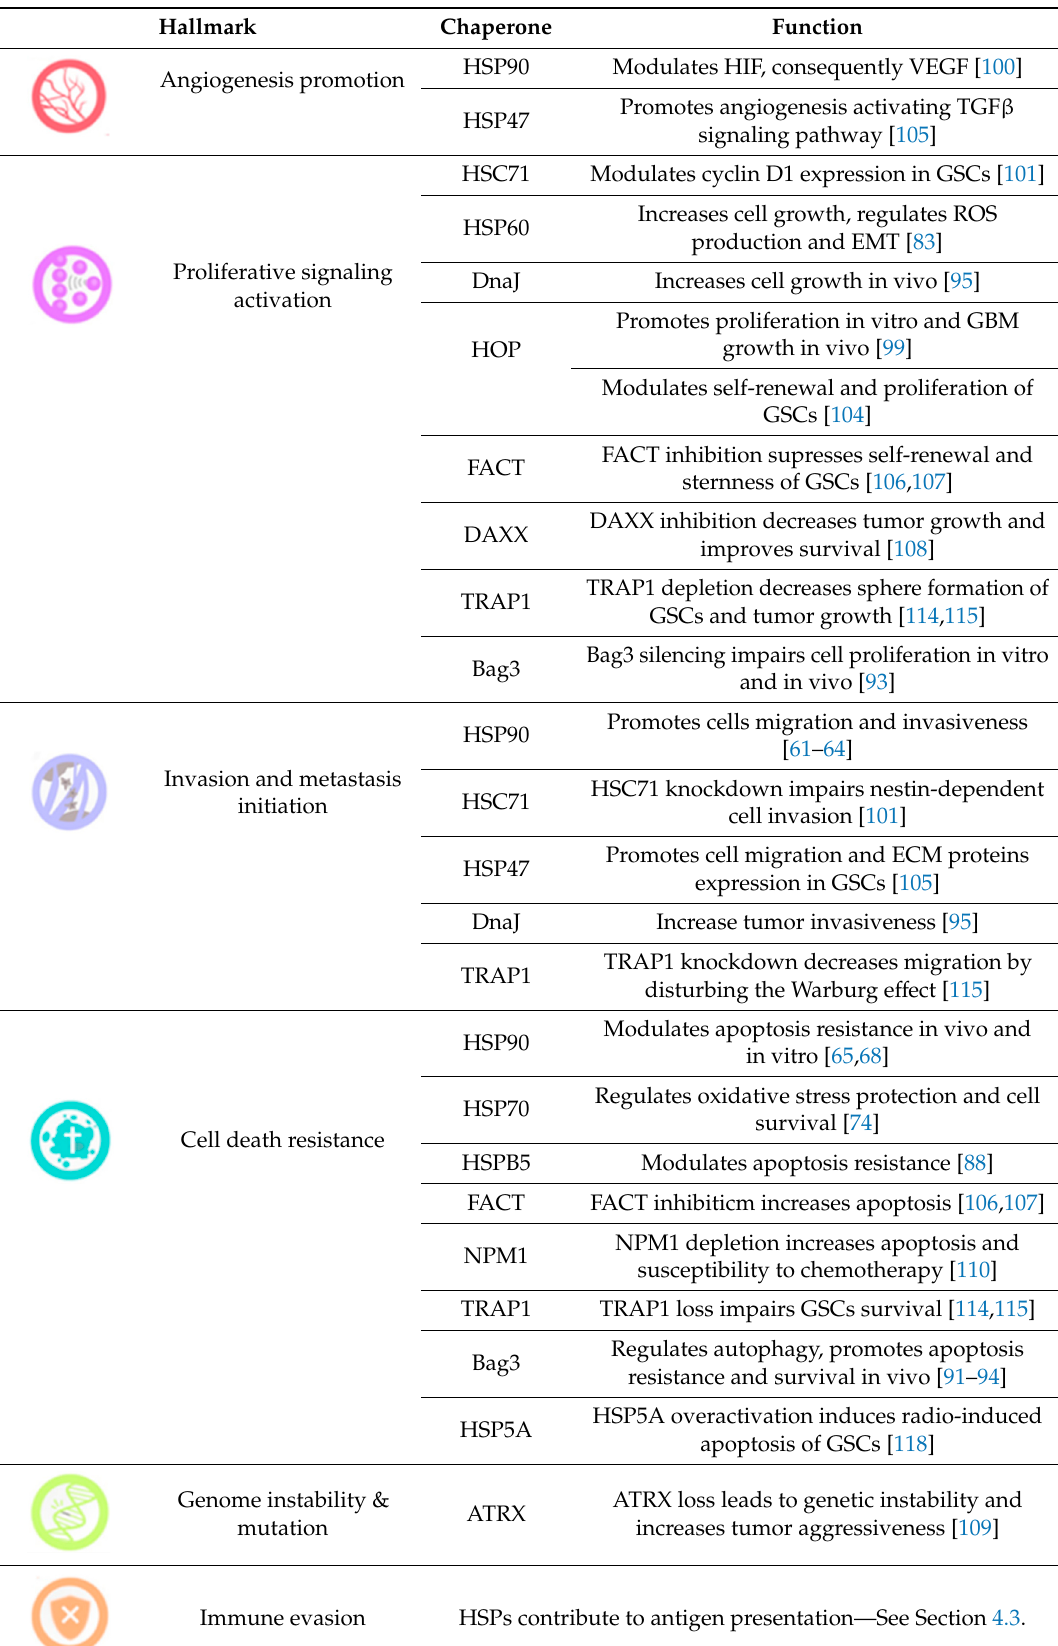
Table 1. Role of HSPs and co-chaperones in glioblastoma (GBM) biology. GSCs, glioblastoma stem-like cells; EMT, epithelial–mesenchymal transition.